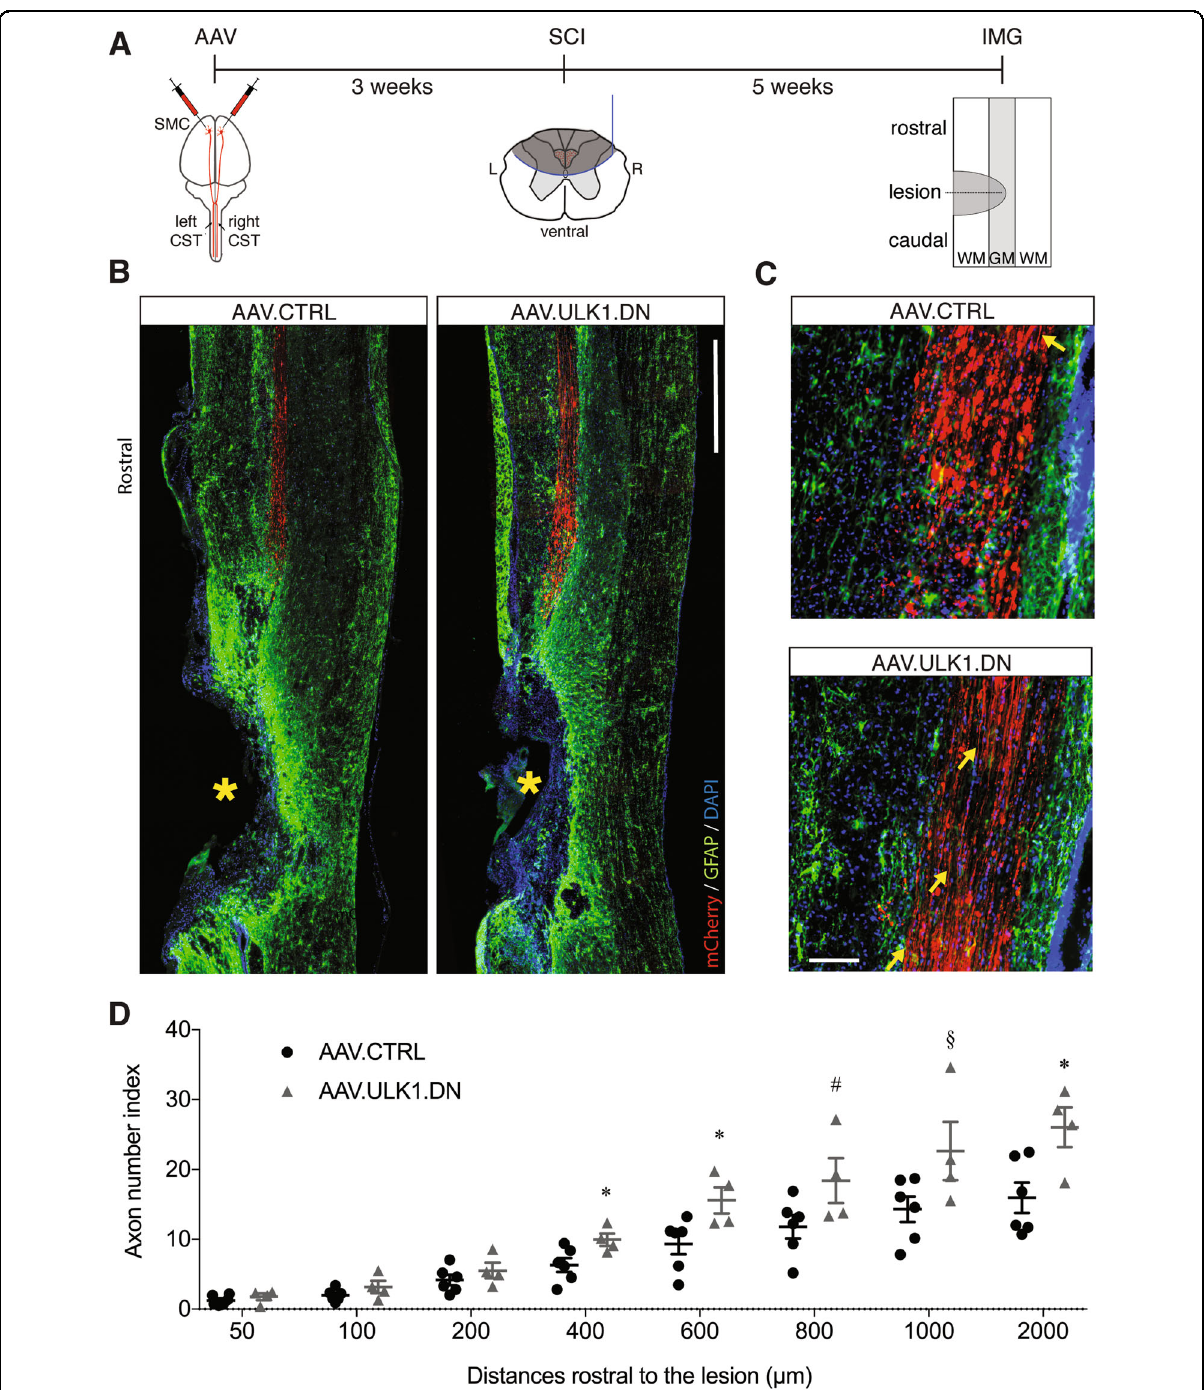
Fig. 5 AAV.ULK1.DN mediates long-lasting axonal protection after spinal cord injury. A Scheme of experimental setup. AAV vectors were injected into both sensorimotor cortices 3 weeks before SCI. Five weeks after SCI, parasagittal spinal cord sections were obtained. AAV: transduction with adeno- associated viral vectors; SMC: sensorimotor cortex; CST: corticospinal tract; SCI: spinal cord injury; L: left; R: right; IMG: imaging; WM: white matter; GM: gray matter. B Representative images of parasagittal spinal cord sections, including the lesion site and rostral region, transduced with given AAV showing mCherry- positive axons (red) and staining for GFAP (green) and DAPI (blue) up to 3000µm rostral to lesion. Asterisks indicate the lesion areas. Scale bar: 1000 μ m. C Higher magni fi cation images of areas at around 2000µm distance from the lesion border. Arrows indicate intact axons. Scale bar: 100µm. D Quanti fi cation of the axon number index (a ratio of intact axon numbers to the total number of transduced axons) at the indicated distances from the lesion border after transduction with AAV.CTRL ( n = 6 animals) and AAV.ULK1.DN ( n = 4 animals). Data are presented as single data points and means±SEM. * P <0.05, # P = 0.08, § P = 0.07, according to two-tailed unpaired t -test for each